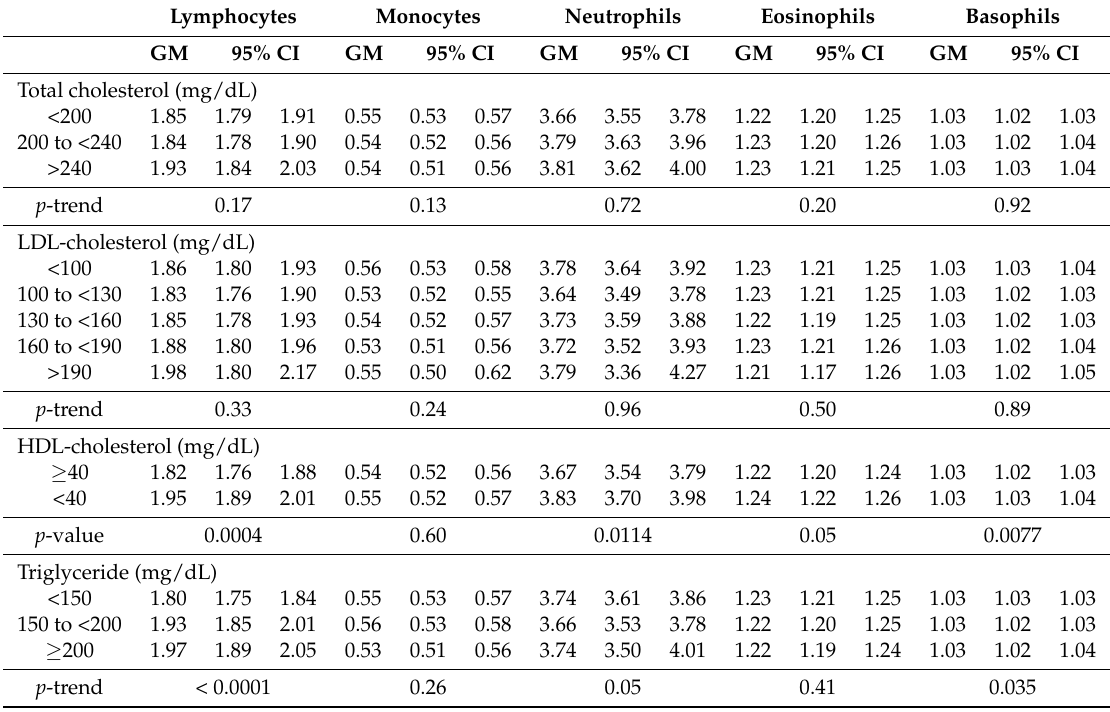
Table 2. Serum lipids are differentially associated with peripheral leukocyte counts in men from NHANES 1999–2004. Lymphocytes Monocytes Neutrophils Eosinophils